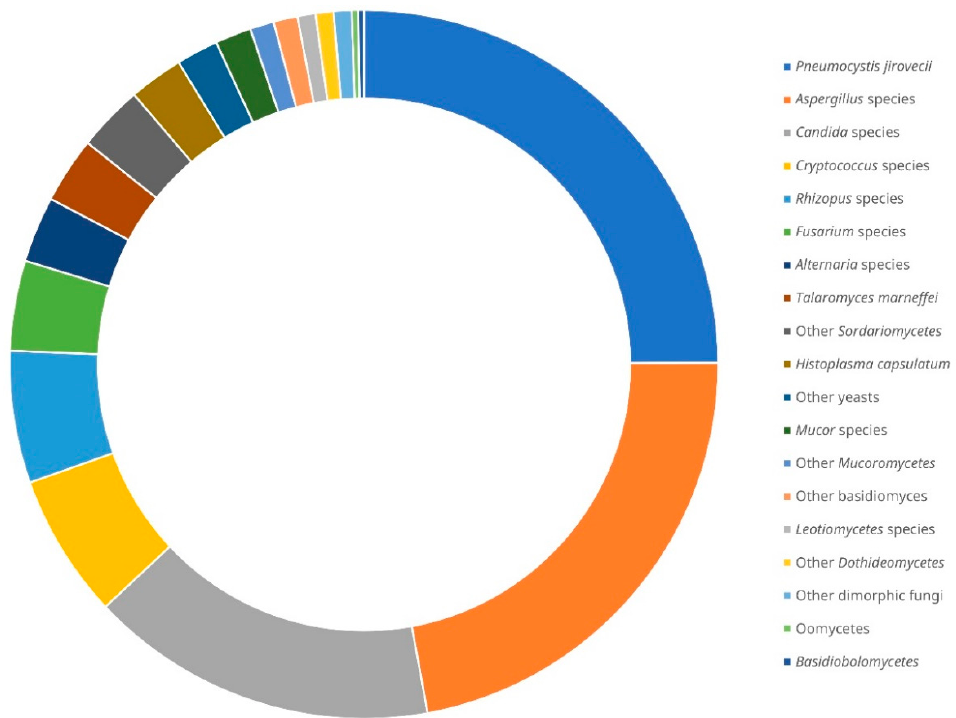
Figure 2. Distribution of fungal species detected by next-generation sequencing from clinical samples of patients with suspected infections reported in the literature [26–77]. There was a total of 319 cases with 365 fungi